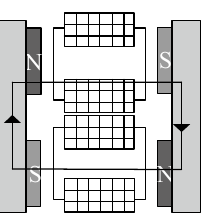
Figure 13 Topology of the YASA structure of an AFPMSM